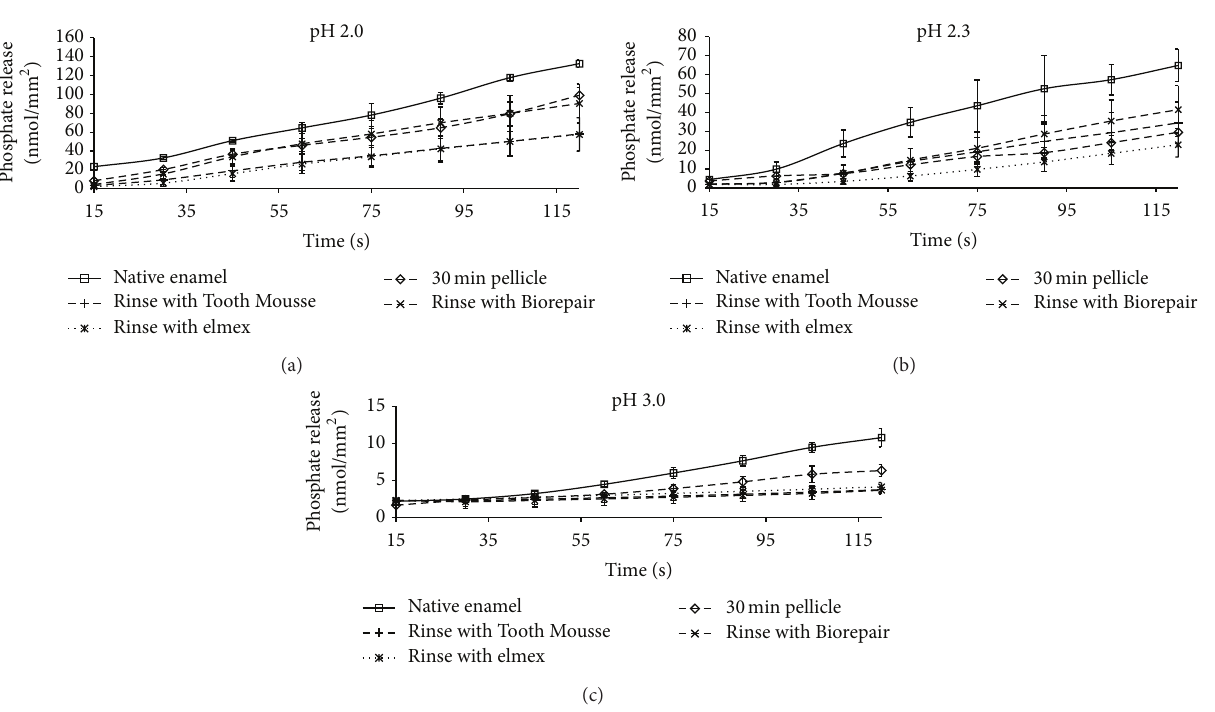
Figure 3: Kinetics of phosphate loss during incubation of enamel slabs for 120 s with and without application of different preparations in situ . Physiological 30 min pellicles (without rinse) and specimens without pellicle served as controls. On the whole, the phosphate release reducing effect of the calcium phosphate and apatite based products appeared inferior to fluoride. Please note the different scale; 𝑛 = 8 subjects; 𝑛 = 24 enamel samples per subgroup; mean values ± standard